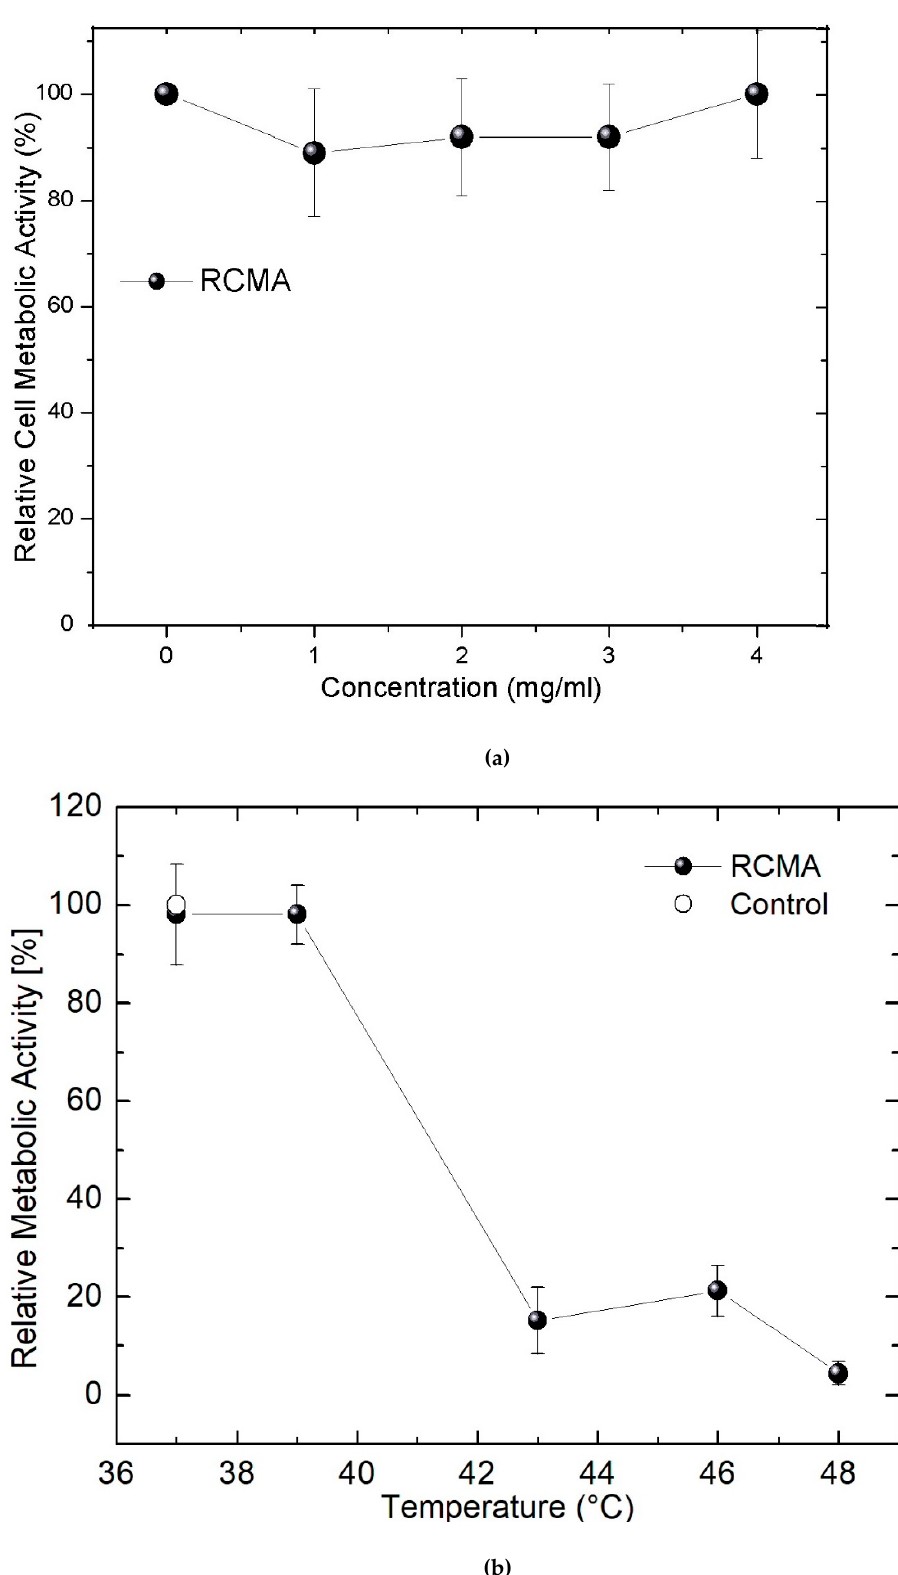
Figure 9. Relative metabolic activity of HT-29 cells ( a ) at different concentrations of coated MNPs and ( b ) after 20 min of magnetic field irradiation (using 3 mg/mL of MNPs, f = 530 kHz and H ranging from 12 kA/m to 20 kA/m).